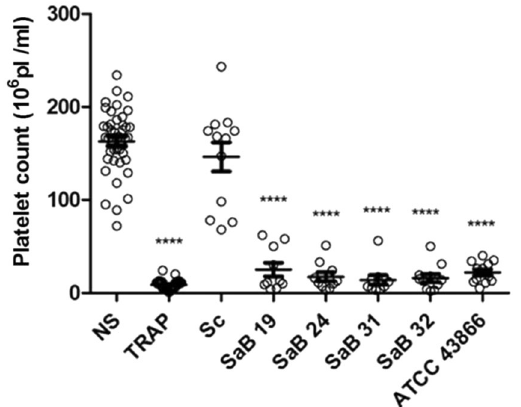
Figure 1. Platelet counts following exposure to Staphylococcus strains. After a 30-min exposure to the staphylococcal strains, TRAP (as a positive control) or Tyrode’s buffer (as a negative control, NS), platelet counts were assessed with a MS4s Hematology analyzer [Tyrode (n = 42), TRAP (n = 40) or Staphylococcus strains: clinical strains (SaB), S. condimenti (Sc) or S. aureus ATCC 43866 (ATCC43866)] (n = 12). The data (mean ± SEM) are expressed as the platelet count × 10 6 /ml **** p < 0.0001 (one-way ANOVA with repeated measures and the Bonferroni post hoc test; stimulated vs . unstimulated,